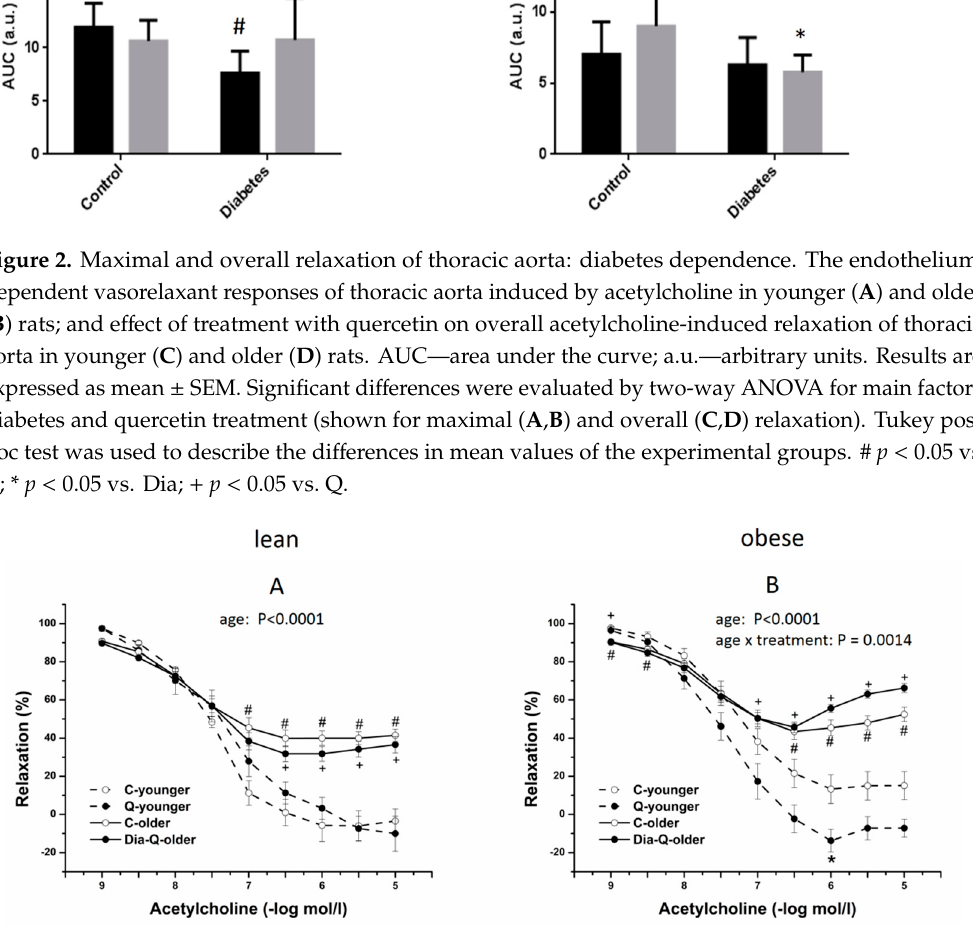
Figure 4. Correlations between maximal relaxation and glycaemia. The mutual relationship between maximal vasorelaxation induced by acetylcholine in thoracic aorta and plasma glucose level in rats without ( A ) and with ( B ) the treatment with quercetin. Max R = maximal relaxation. 2.4. Effect of QCT on Post-Ischemic Recovery and Infarct Size in Isolated Hearts We evaluated effect of QCT on resistance of isolated hearts from ZDF rats to I/R injury by measuring post-ischemic recovery of hemodynamic parameters of isolated Langendorff-perfused hearts in the 40th minute of post-ischemic reperfusion, and by evaluating infarct size in relation to area at risk. Firstly, there were no significant differences in baseline (pre-ischemic) values of all hemodynamic parameters measured at the end of stabilization period just before initiation of 30-min global ischemia in the hearts from younger rats (6-month-old) (Table 2). In the hearts from older (1- year-old) rats, there were significantly increased left ventricular developed pressure (LVDP) ( p < 0.001), +(dp/dt) max ( p < 0.05), − (dp/dt) max ( p < 0.05) and coronary flow rate ( p < 0.001) in obese hearts as compared to hearts from age-matched lean controls, while heart rate was significantly decreased ( p < 0.01) in obese hearts as compared to lean controls (Table 2). Finally, there were no differences in rate- pressure products (RPP, heart rate x LVDP) among the groups before ischemia (Table 2).